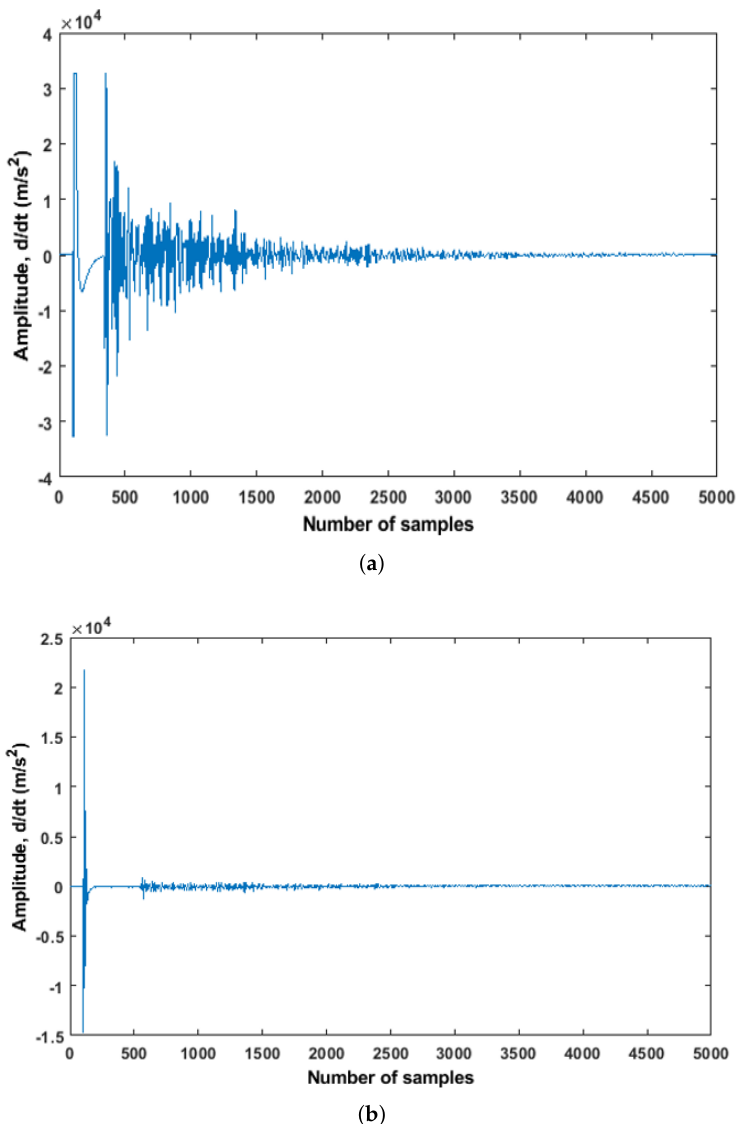
Figure 12. Raw signal acquired from the bridge in Gliwice. ( a ) Raw signal acquired from the sensors pair S01R02 in the Gliwice bridge; ( b ) Raw signal acquired from the sensors pair S02R08 in the Gliwice